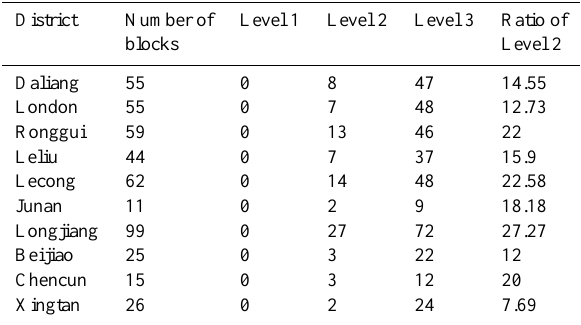
Table 6. The potential level of each town.